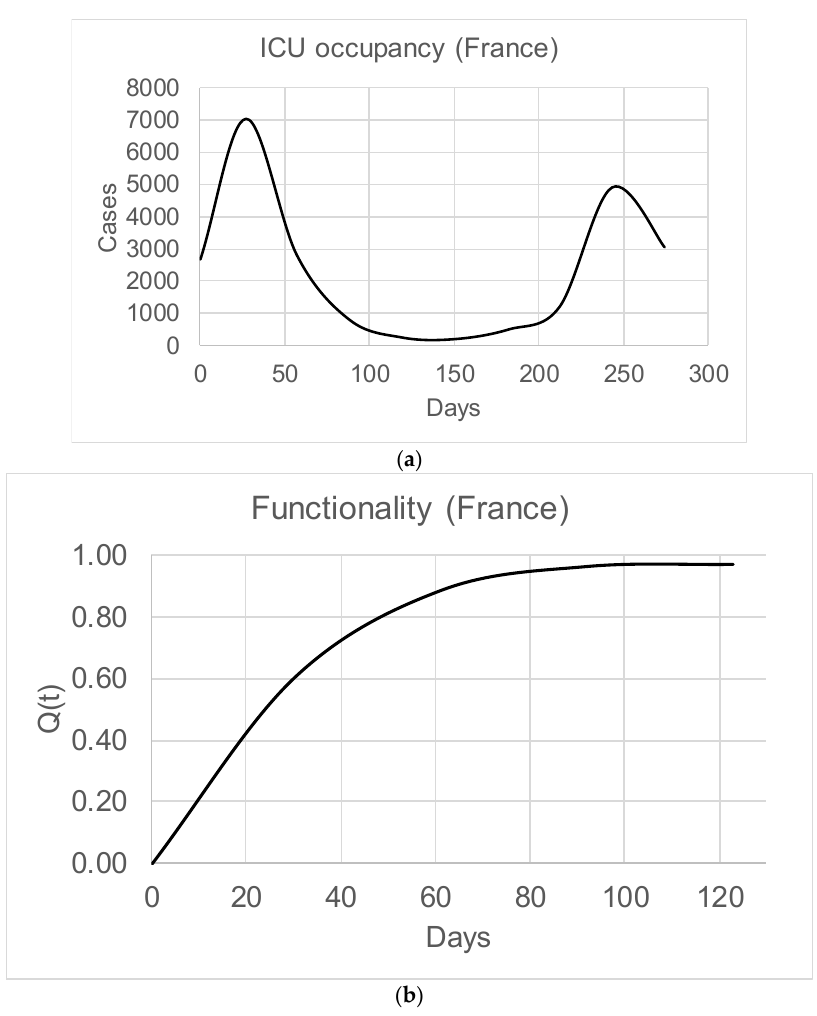
Figure 4. ( a ) Number of COVID-19 patients in ICU in France from 7 April 2020 to 7 December 2020. Source: Health Ministry and Santé Publique France. ( b ) Health Infrastructure functionality vs. days in France (T = 123 days).